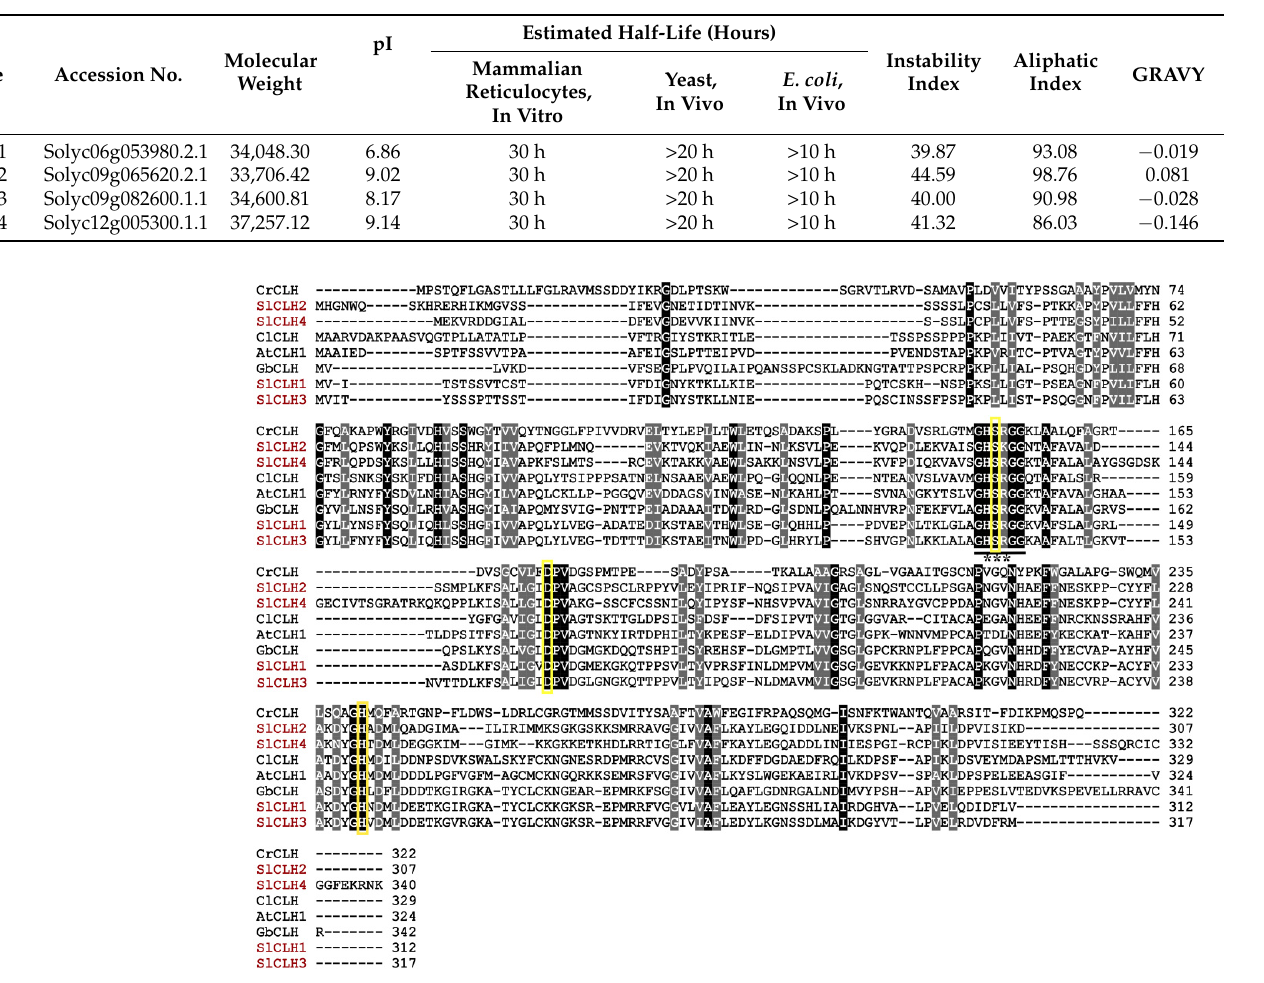
Table 1. Physical and biochemical parameters of SlCLHs predicted with the ProtParam tool.